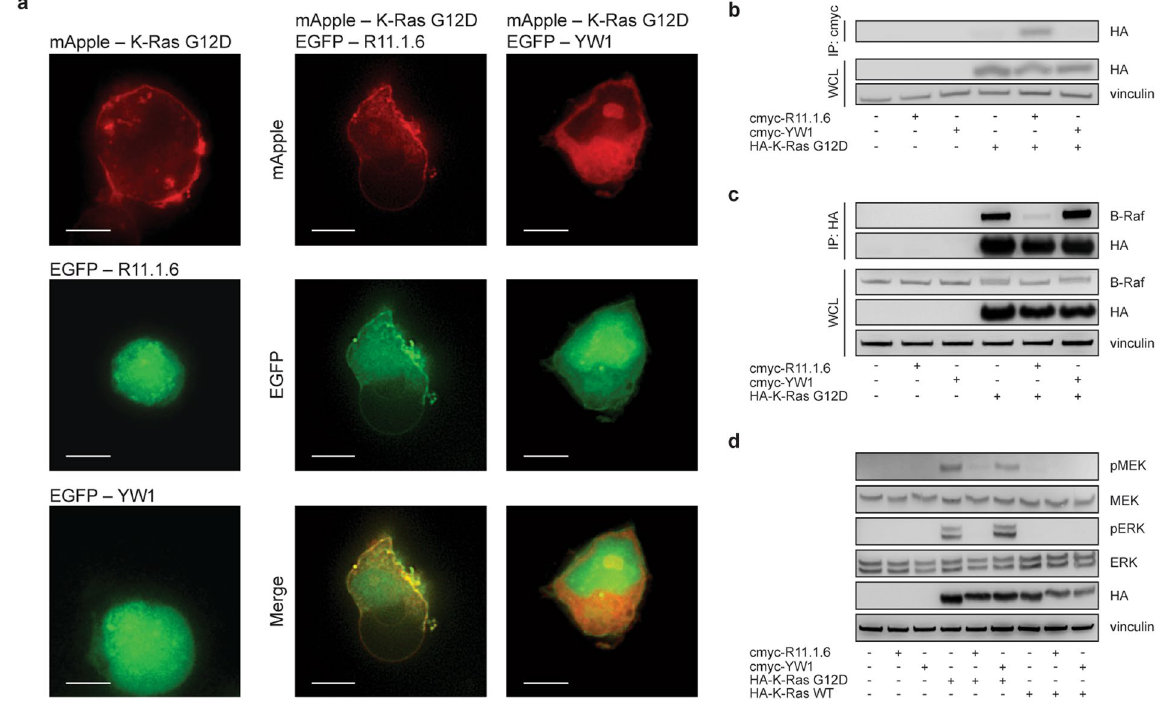
Figure 4. R11.1.6 specifically binds K-Ras G12D in cells, blocks K-Ras-B-Raf interaction, and inhibits signaling. ( a ) Co-localization of EGFP-R11.1.6 (green) with mApple-K-Ras G12D (red) in co-transfected HEK 293T cells. Scale bars are 10 μ m. Images are representative of n = 2 biological replicates. Co-localization is quantified in Extended Data Figure 5a. ( b ) Co-immunoprecipitation of HA-tagged K-Ras G12D with cmyc-R11.1.6/YW1 in co-transfected HEK 293T cells, showing R11.1.6 specificity for K-Ras G12D. IP, immunoprecipitation; WCL, whole cell lysate. Results are representative of n = 2 biological replicates. ( c ) Co- immunoprecipitation of endogenous B-Raf with HA-tagged K-Ras G12D in co-transfected HEK 293T cells, showing inhibition of K-Ras-B-Raf binding by R11.1.6. Results are representative of n = 3 biological replicates. ( d ) Effect of R11.1.6 on phosphorylation of endogenous MEK (pMEK) and ERK (pERK) via HA-K-Ras G12D- induced signaling in co-transfected HEK 293T cells, showing inhibition of signaling by R11.1.6. Results are representative of n = 3 biological replicates. Quantification is provided in Extended Data Figure 5e. Full-length blots of the cropped ones shown here are given in Extended Data Figures 6, 7, and